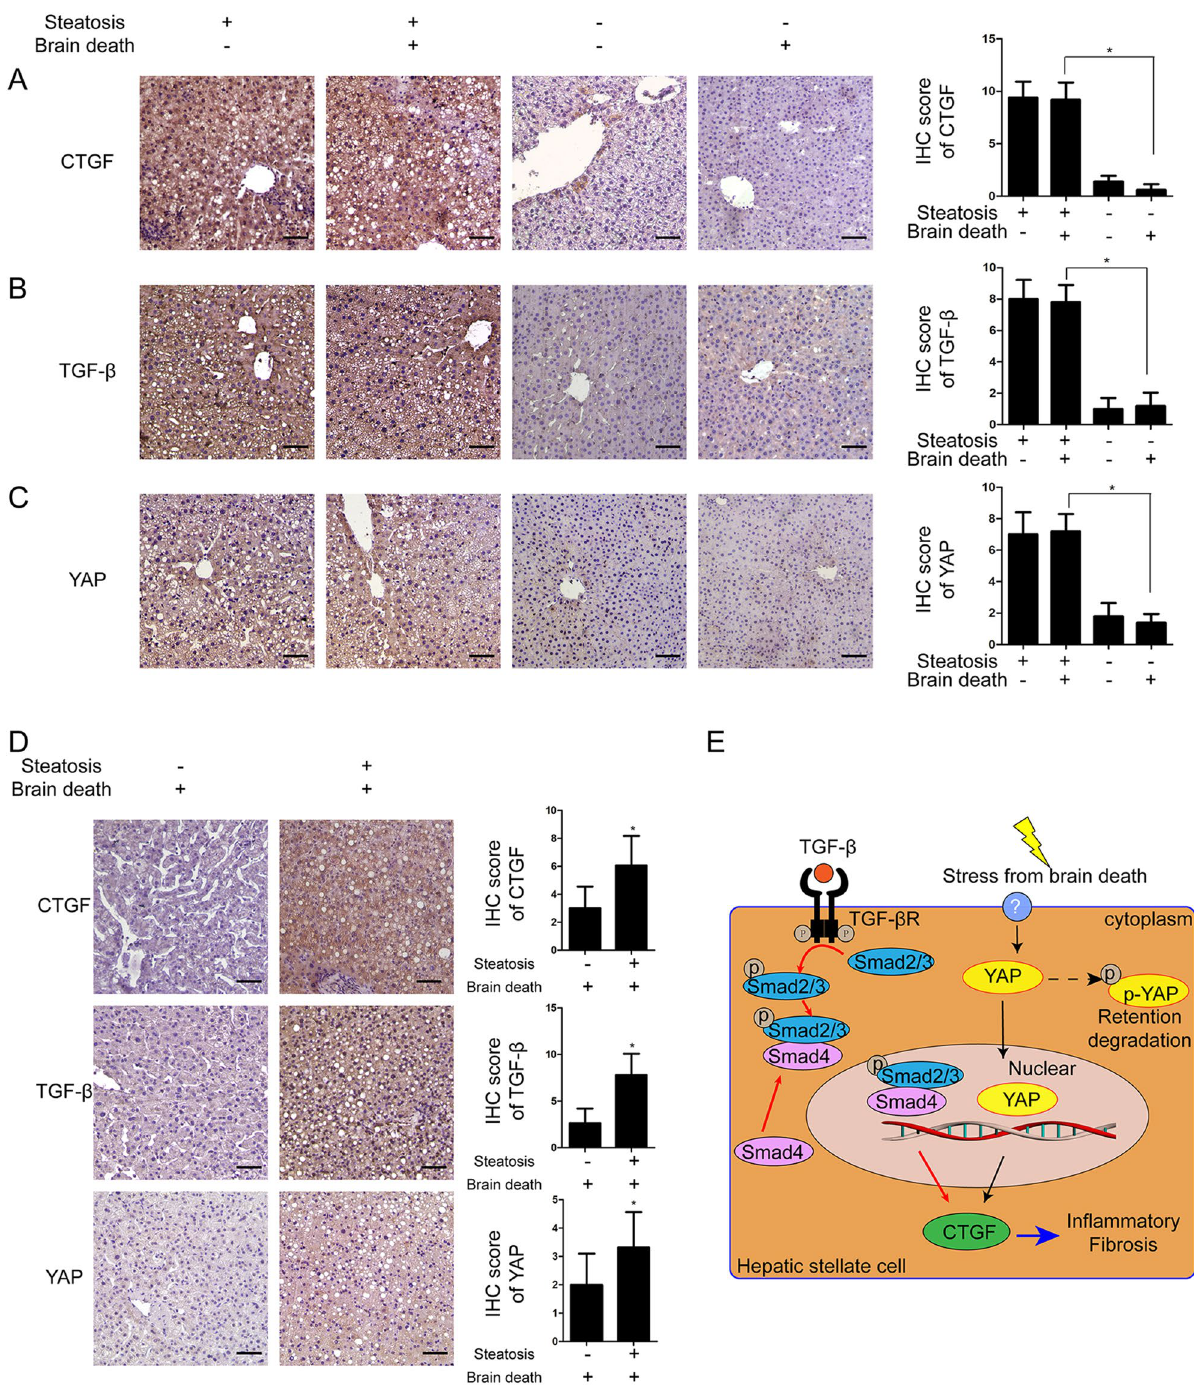
Figure 5. Expression of CTGF, YAP and TGF-β in non-steatotic liver and non-alcoholic steatotic liver under brain death. Expression of ( A ) CTGF, ( B ) TGF-β, and ( C ) YAP in the non-steatotic liver and non-alcoholic steatotic liver before and after brain dead in rats; n = 5 per group, scale bar = 20 μm, ×200 magnification (* P < 0.05 between the non-steatotic liver and non-alcoholic steatotic liver after brain death). ( D ) Expression of CTGF, TGF-βand YAP in human non-steatotic and non-alcoholic steatotic liver tissues (scale bar = 20 μm, ×200 magnification, n = 6). ( E ) Schematic of the proposed mechanism of CTGF regulation in the non-alcoholic steatotic liver after brain